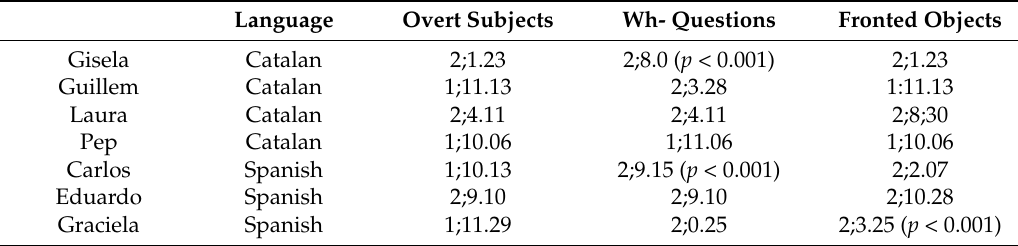
Figure 1. Left-Peripheral subjects in Spanish; IP-internal subjects in English. Table 1. Ages of onset and binomial test result of overt subjects, wh-questions and fronted objects in 4 Catalan-speakers and 3 Spanish-speakers, compiled from Grinstead and Spinner (2009, Tables 3 and 4, pp. 66–67).